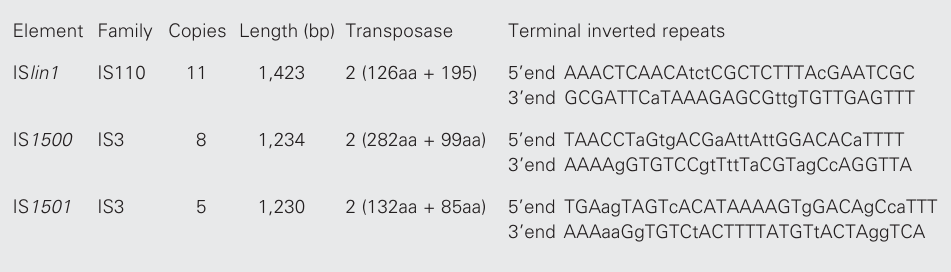
Table 2. Insertion sequence (IS) elements present in Leptospira interrogans serovar Copenhageni .